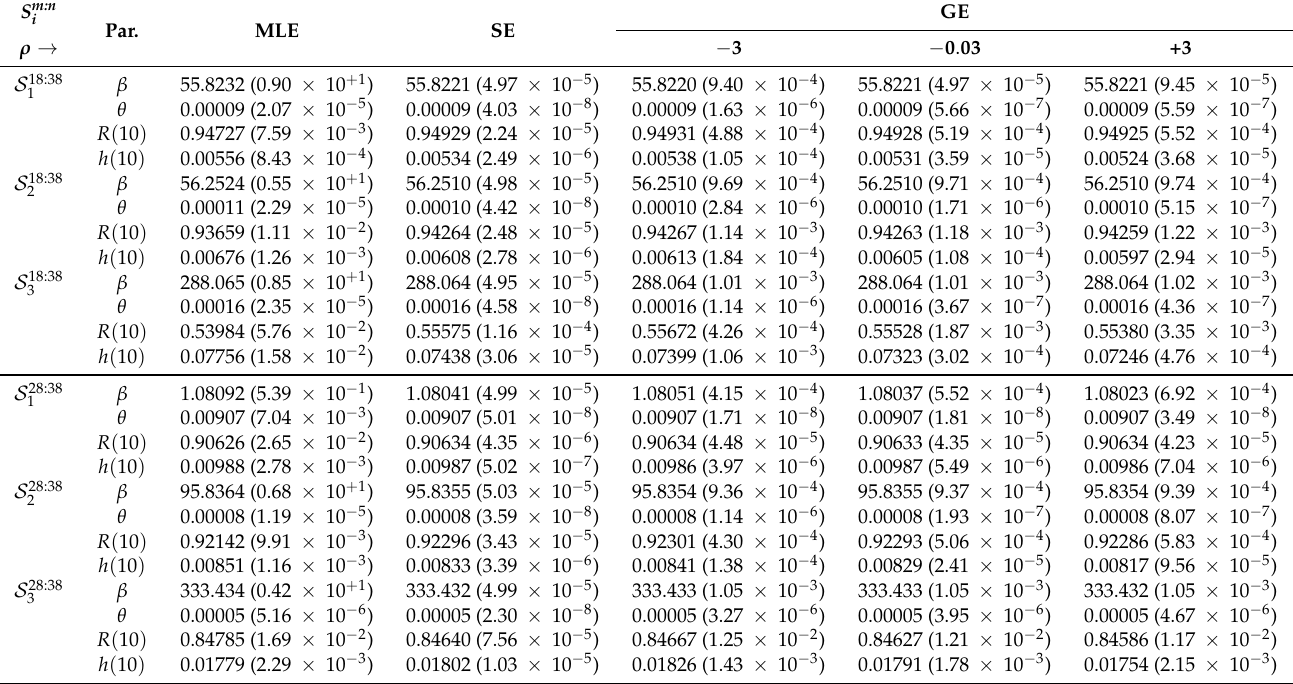
Table 2. The point estimates (St.Es) of β , θ , R ( t ) , and h ( t ) under MTS data.